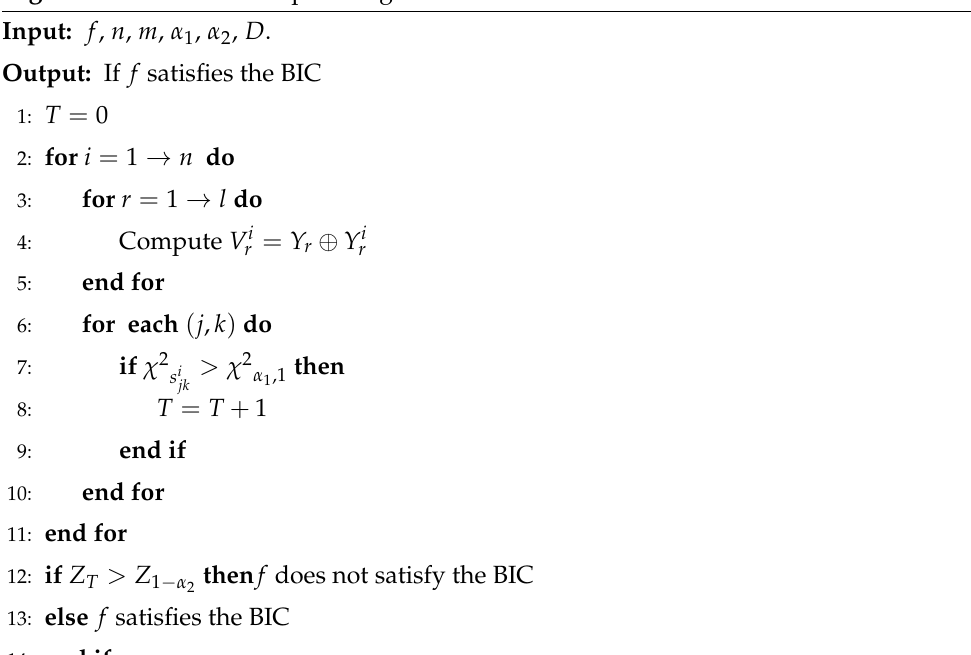
Algorithm 2 BIC stream ciphers